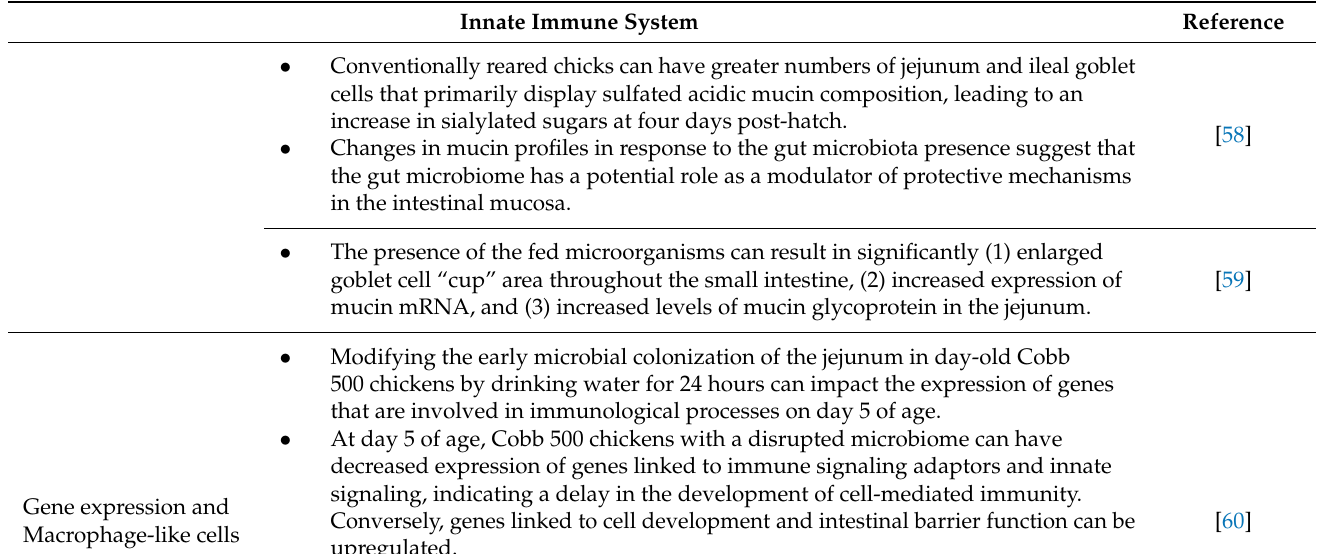
Table 1. Cont. Innate Immune